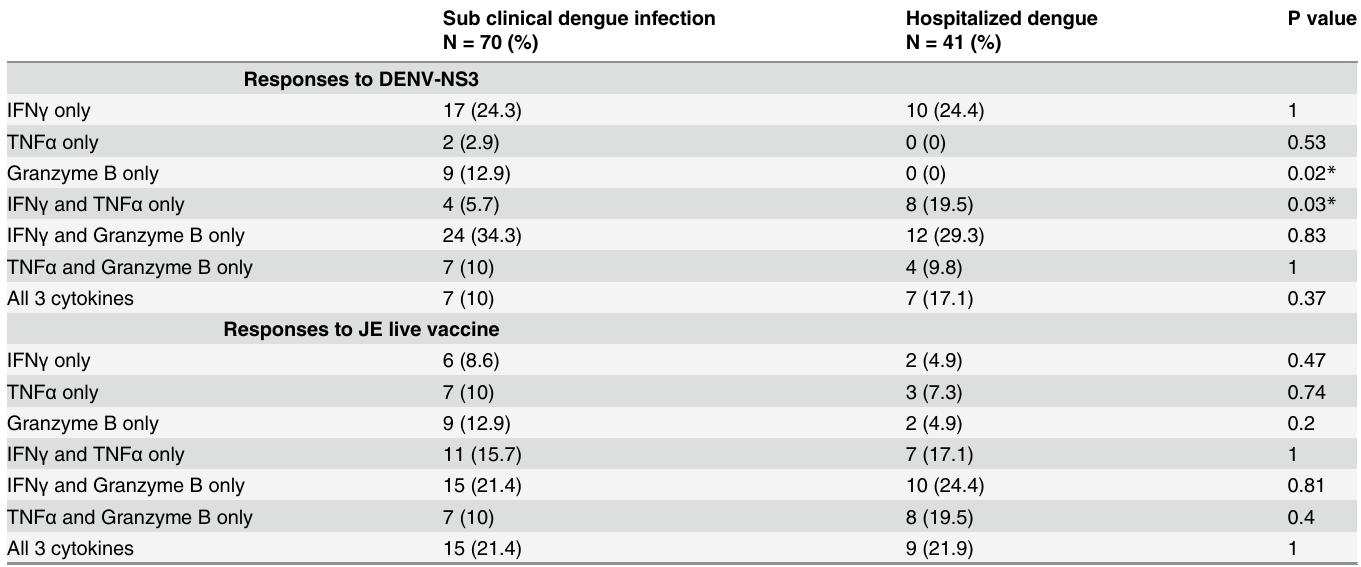
Table 1. Number and percentage of individuals with mild/sub clinical dengue infection and those who were hospitalized due to dengue who pro- duced of different cytokines when PBMCs were stimulated DENV-NS3 overlapping peptides and JE Live